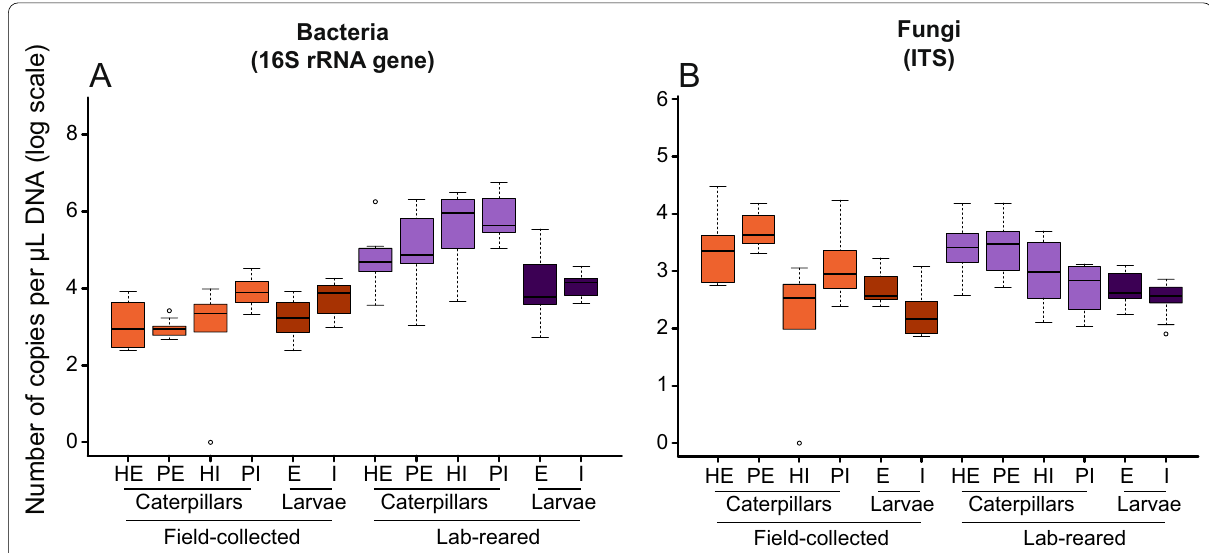
Fig. 3 Boxplots showing the numbers of bacterial 16S rRNA gene ( A ) and fungal ITS copies ( B ) for the different caterpillars ( Pieris brassicae ) and parasitoid larvae ( Cotesia glomerata ) samples studied. Samples were divided in different subgroups according to habitat, organism, health status and origin for caterpillars, and habitat and origin for parasitoid larvae. The upper and lower whiskers correspond to the first and third quartiles, with the bar in the middle marking the median value. For each subgroup, ten random samples were analyzed. Abbreviations used: H P parasitized; E external; and I = = =